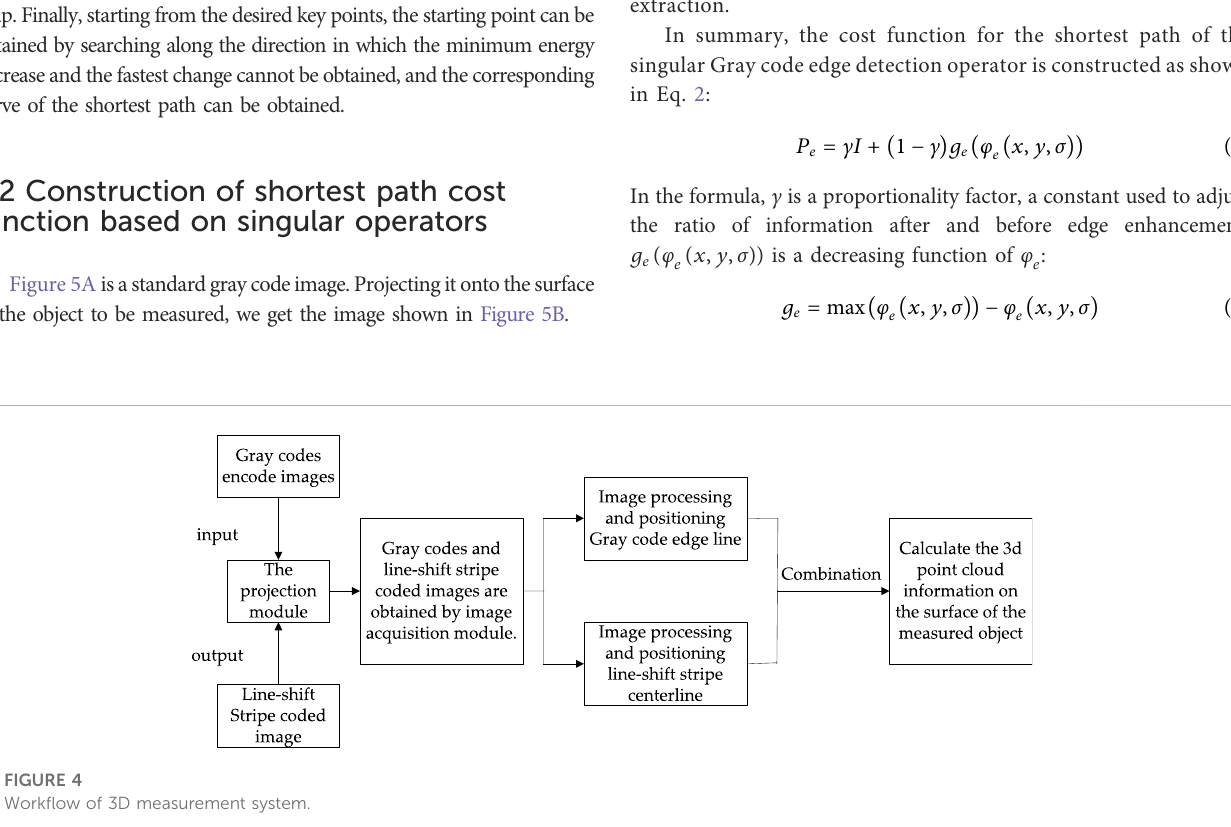
FIGURE 4 Work fl ow of 3D measurement system.